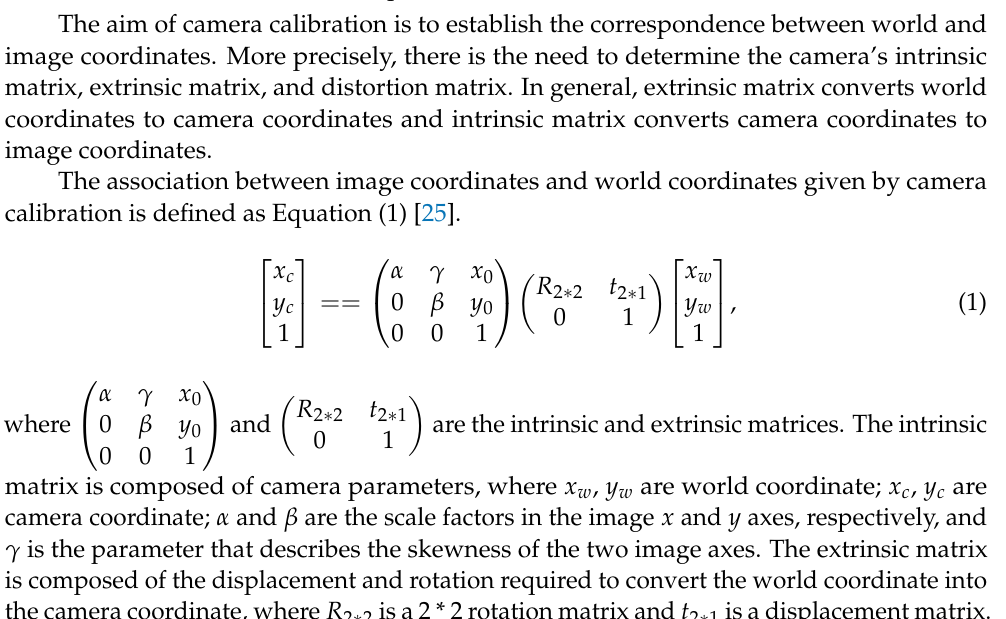
Table 1. Chemical composition and particle-size distribution of FeSiCr powder [21]. Materials Chemical Composition Particle Size Distribution (%) Fe-Si 3.5 -Cr